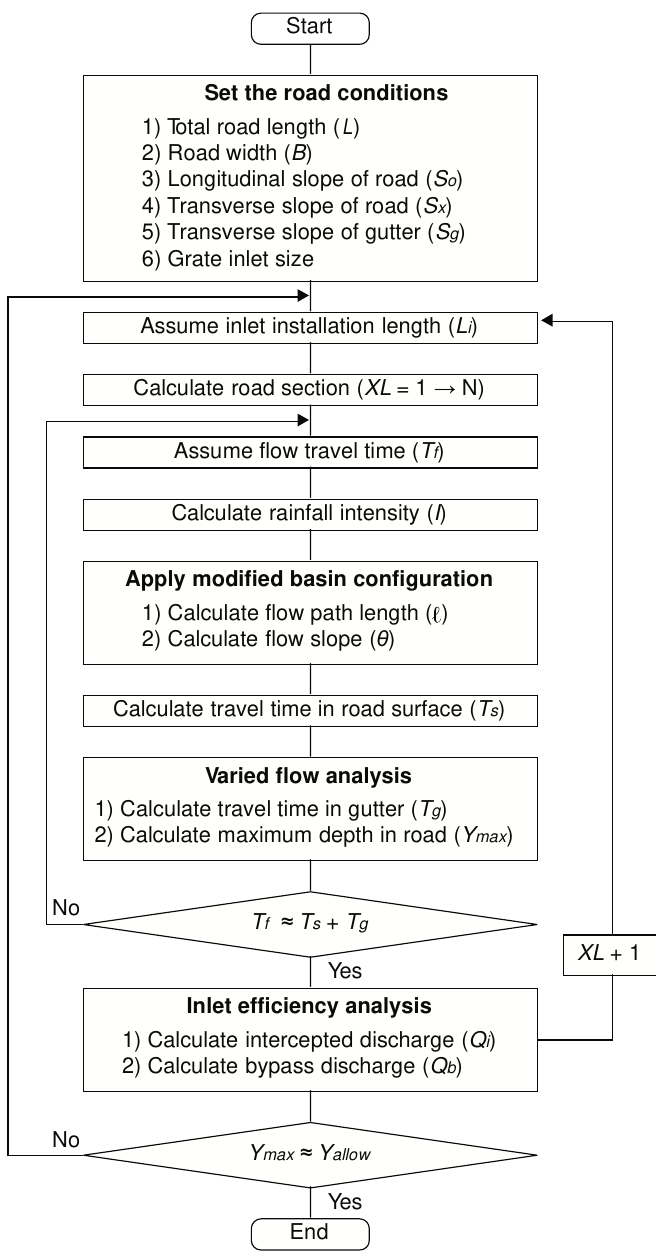
Figure 8. Optimal method for the road surface-runoff analysis.